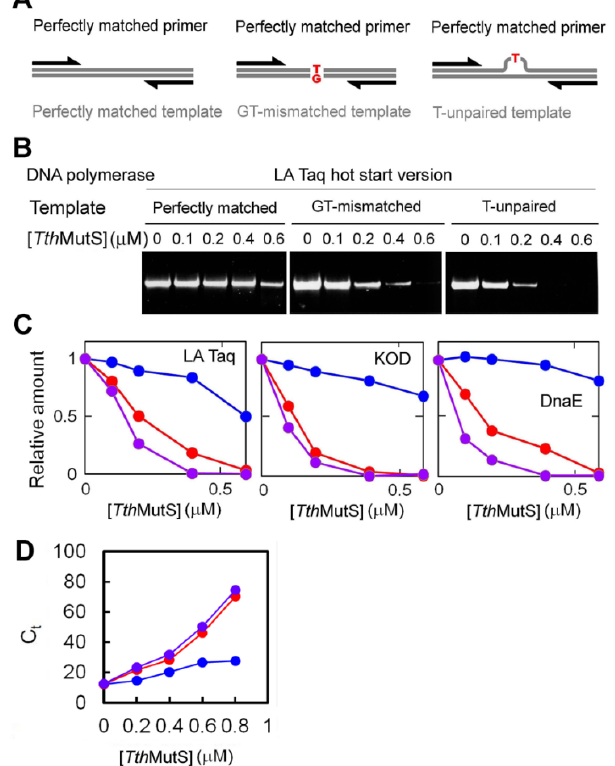
Figure 4. Effects of Tth MutS on standard PCR amplification of mismatched templates. ( A ) Schematic representations of the primers and templates used in ( B , C ); ( B ) A perfectly matched primer was used to amplify perfectly matched (left), GT-mismatched (middle) or unpaired T-containing (right) templates; ( C ) Relative amounts of amplified fragments from reactions using perfectly matched (blue), GT-mismatched (red) or unpaired T-containing (purple) templates were plotted against the Tth MutS concentration. The amounts of the products were normalized by those at 0 μ M Tth MutS; ( D ) The effect of Tth MutS on amplification of the 80-bp mismatched template was examined by real-time PCR. The perfectly matched (blue), GT-mismatched (red) and unpaired T-containing (purple) templates were amplified by AmpliTaq Gold DNA polymerase by using perfectly matched ) was determined and plotted against the Tth MutS primers. The threshold cycle ( C t concentration. Experiments were repeated three times. Bars indicate standard